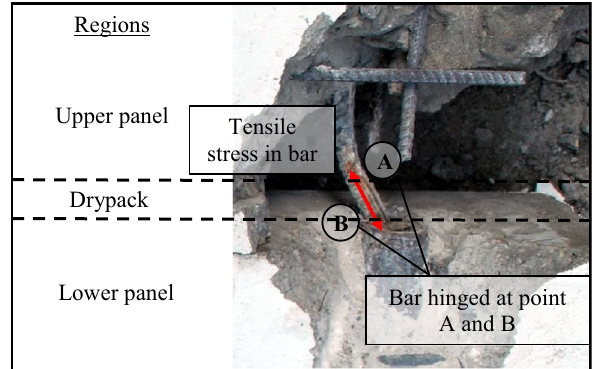
Fig. 10 The deformation of the bars after bar dowel action (specimen